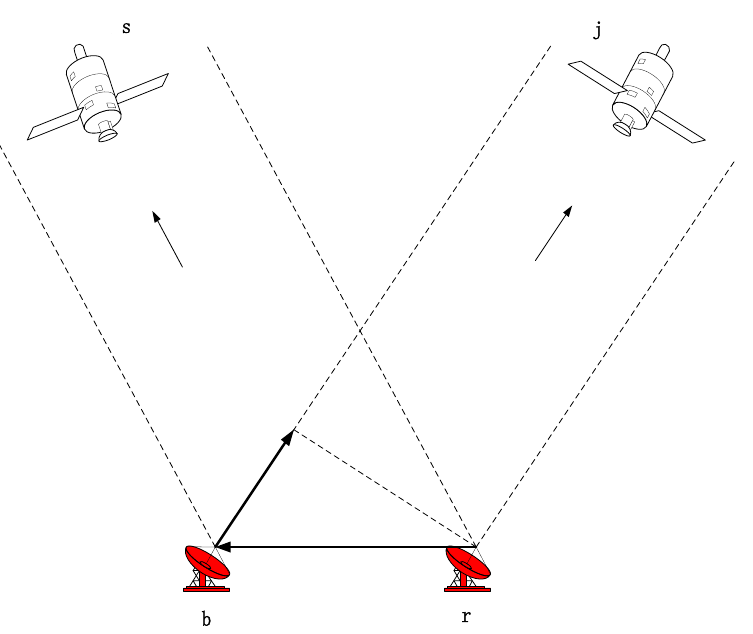
Figure 1. Geometric diagram of double-difference model.